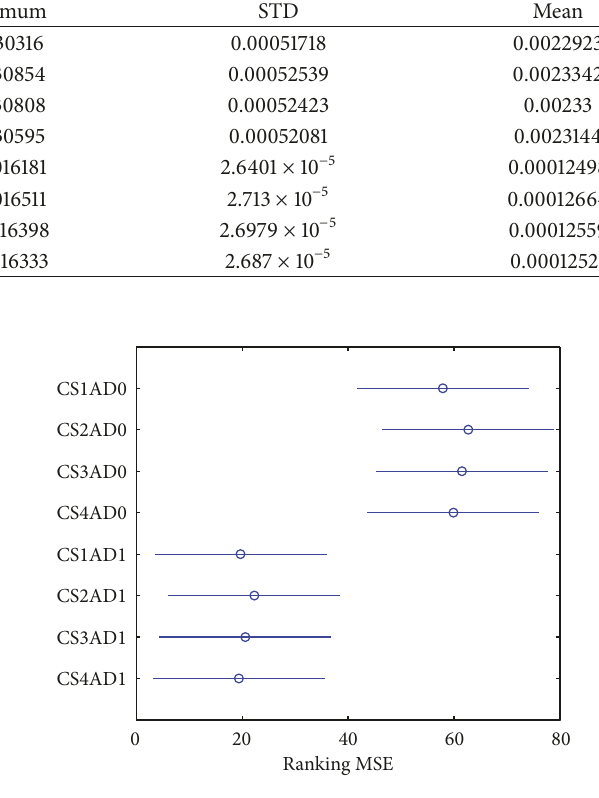
Figure 20: Results of multiple